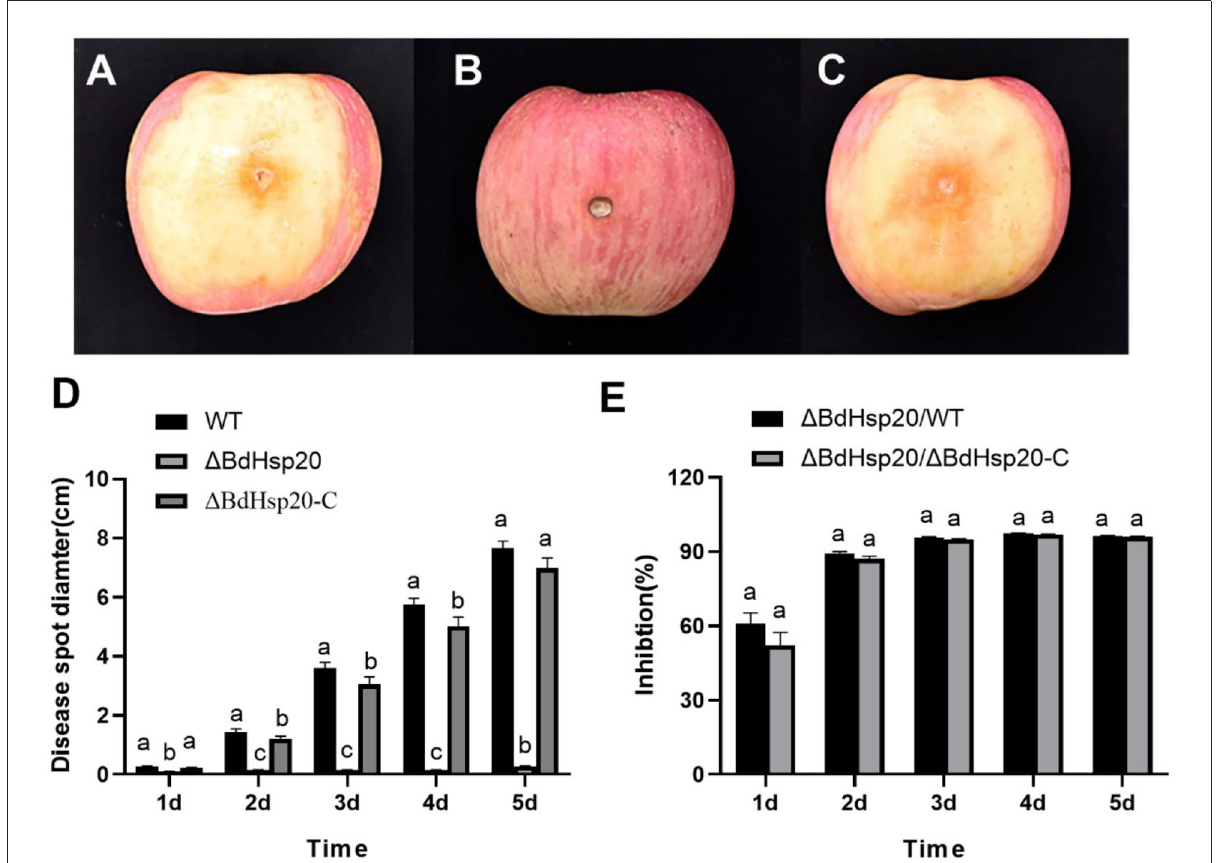
FIGURE9 Pathogenicity of Botryosphaeria dothidea . The apple fruit inoculated with the wild-type strain (A) , the CRISPR/Cas9 gene-edited BdHsp20 strain ( 1 BdHsp20) (B) , and the BdHsp20 complemented strain ( 1 BdHsp20_C) (C) for 5 days. The disease spot diameter on apple fruit inoculated with the three strains was significantly different (D) . Compared to the wild type ( 1 BdHsp20/WT) and 1 BdHsp20_C ( 1 BdHsp20/ 1 BdHsp20_C), BdHsp20 gene deletion significantly reduced the pathogenicity of Botryosphaeria dothidea on postharvest apple fruits (E) . Lowercase letters indicate significant differences between treatments or times ( P <